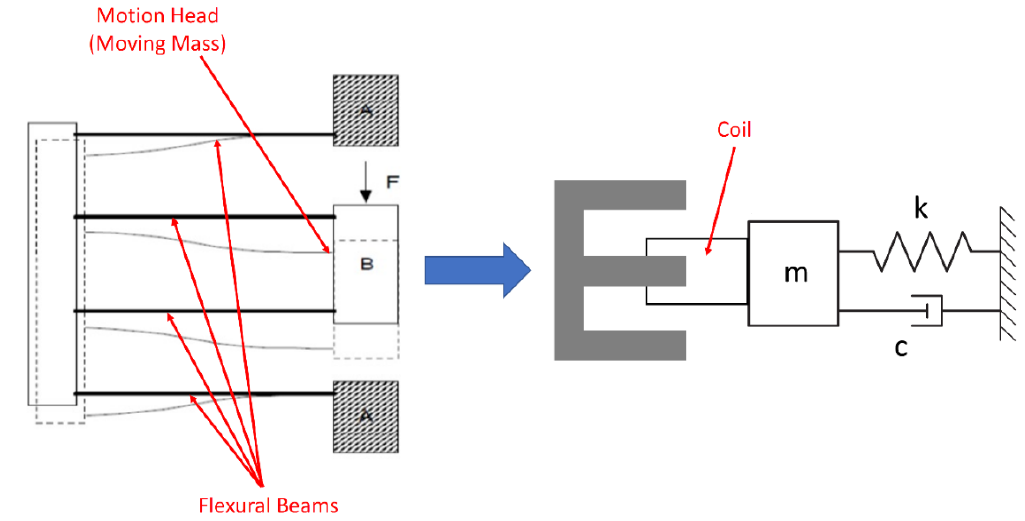
Figure 2. Representation of the double parallelogram flexural (DPF) with the voice coil motor (VCM) in an electromechanical model.